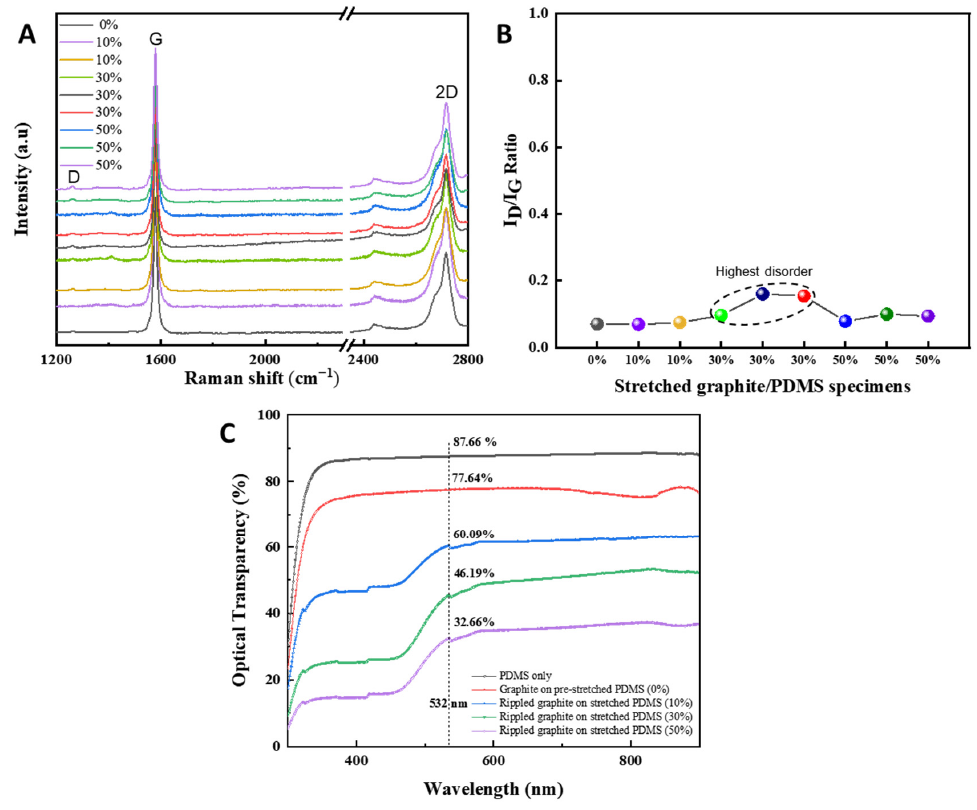
Figure 3. ( A ) Raman spectra of multiple specimens of graphite/PDMS under different stretch:release ratios. ( B ) I D :I G ratios of graphite/PDMS specimens in ( A ). ( C ) Optical transparency of graphite/PDMS specimens under different stretch:release ratios (0%, 10%, 30%, and 50%).